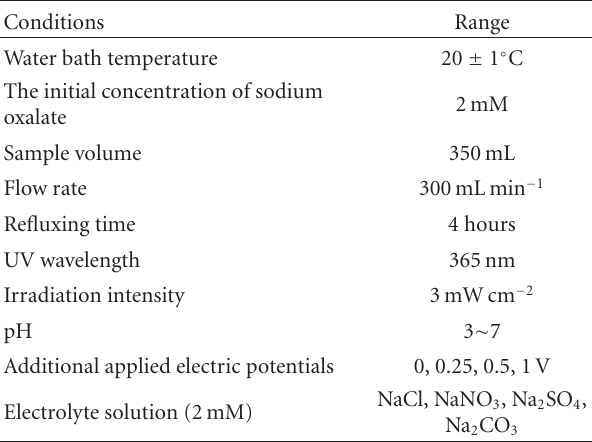
Table 1: Reaction